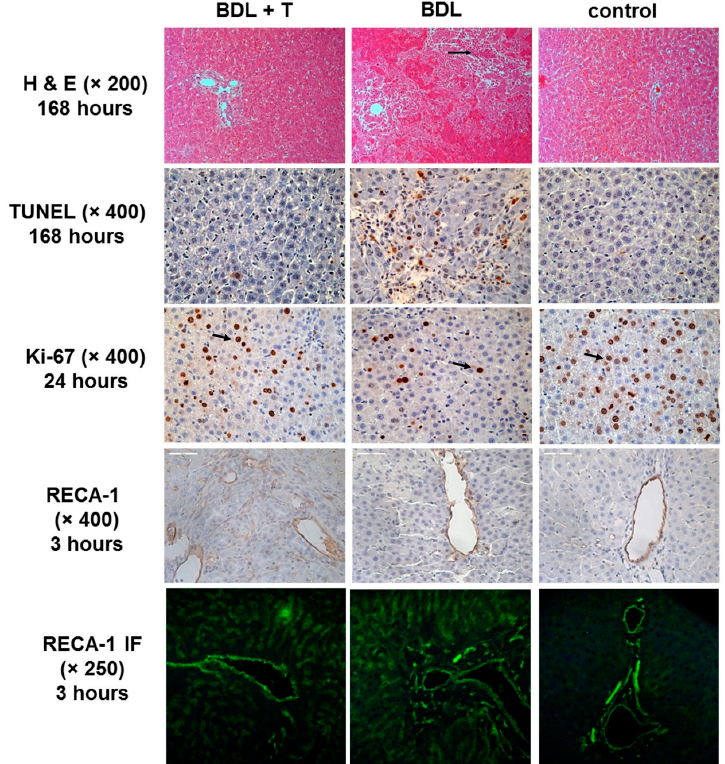
Figure 8. Representative images showing HE staining (1rst row, 200×, 168 h after reperfusion), TUNEL staining (2nd row, 400×, 168 h after reperfusion), Ki-67 stain in g (3rd row, 400×, 24 h after reperfusion, arrows), immunohistochemical RECA-1 staining (4th row, 400×), and immunofluorescence RECA-1 staining (5th row, 250×) in liver sections at indicated time points. Arrow in HE section indicates inflammatory cells. Arrows in Ki-67 sections mark proliferating Kupffer cells and sinusoidal endothelial cells. Significant histopathological changes were also manifested by the presence of the proliferation of biliary epithelium (Figure 8, Ki-67) with the formation of bile ductules (Figure 8, HE and Figure S2). In addition, proliferation of Kupffer cells and sinusoidal endothelial cells (Figure 8, Ki-67), and infiltration of inflammatory cells were found (Figure 8, HE arrow). These changes were most pronounced in the BDL group and abrogated in the BDL + T group compared to the control group. This was also confirmed by RECA-1 staining for endothelial cells. Representative staining for HE, TUNEL, Ki-67, and RECA-1 (IHC and 2-Photonmicroscopy) are shown in Figure 8 for the indicated time points and magnifications. More representative pictures of HE stained liver section at a magnification of 100× are shown in Supplemental Figure S2.